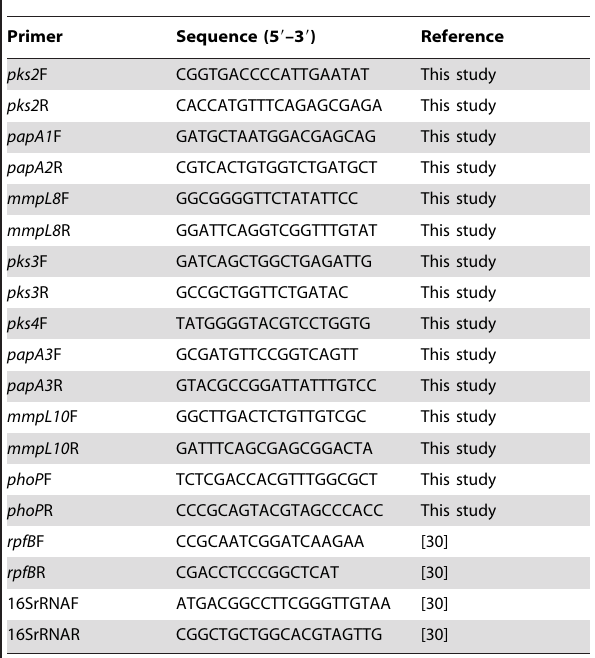
Table 1. Primers for qRT-PCR used in this